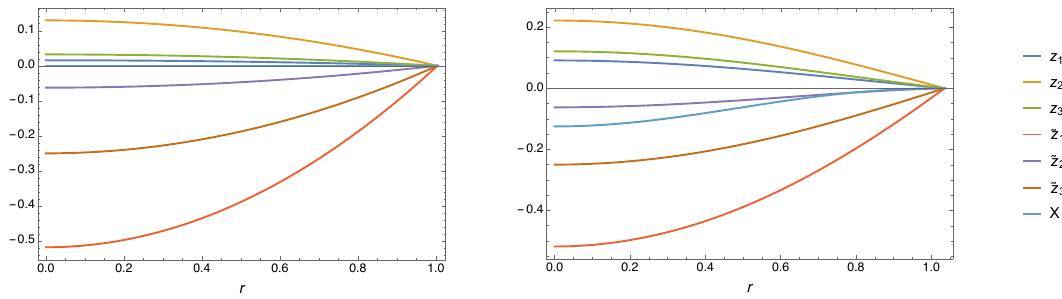
Figure 5 . Solutions for x 0 = 0 (left) and x 0 = (cid:0) 0 : 125 (right) and ~ c 1 = (cid:0) 0 : 5181, ~ c 2 = (cid:0) 0 : 0625, ~ c 3 = (cid:0) 0 :